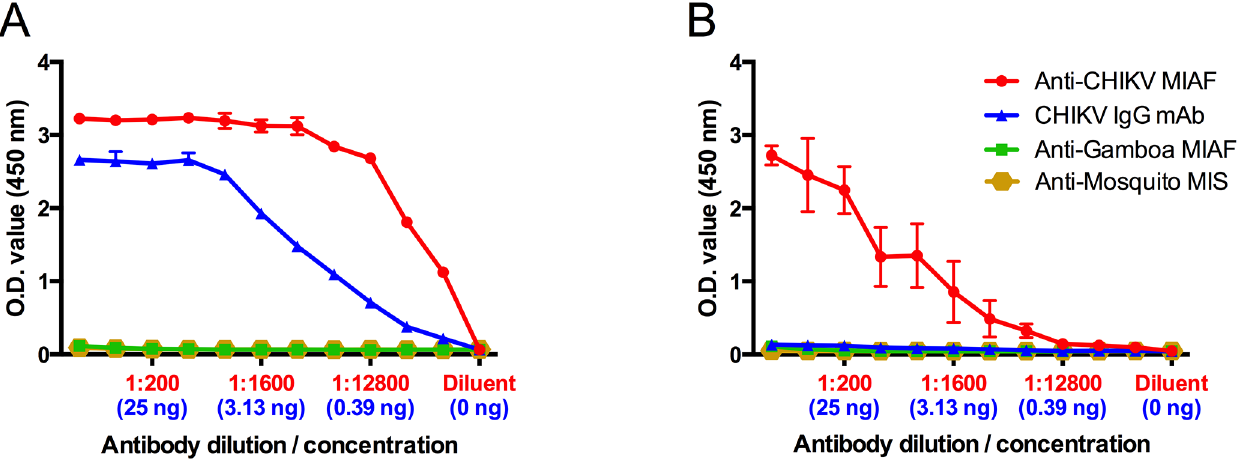
Fig 1. Indirect mouse anti-CHIKV IgG ELISAs utilizing either (A) EILV/CHIKV or (B) cell-lysate antigen to detect serially diluted polyclonal anti- CHIKV MIAF (measured over a range of serum dilutions, red) or monoclonal antibody CHK-175 (expressed in ng quantities, blue). MIAF against Gamboa virus and MIS against mosquito antigens were included as negative controls. Mean and standard deviation of 2 replicates are